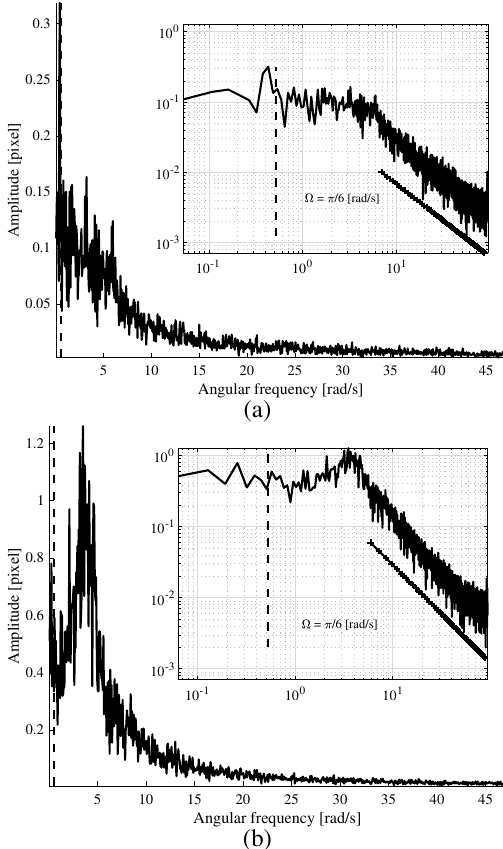
Figure 4. Influence of rotation speed on SSA spectra (the results ⇡ / 4 , ⇡ / 3 for ⌦ = [rad / s] were o ↵ set for legibility): (a) spherical { } particles and (b) polyhedral particles in the large